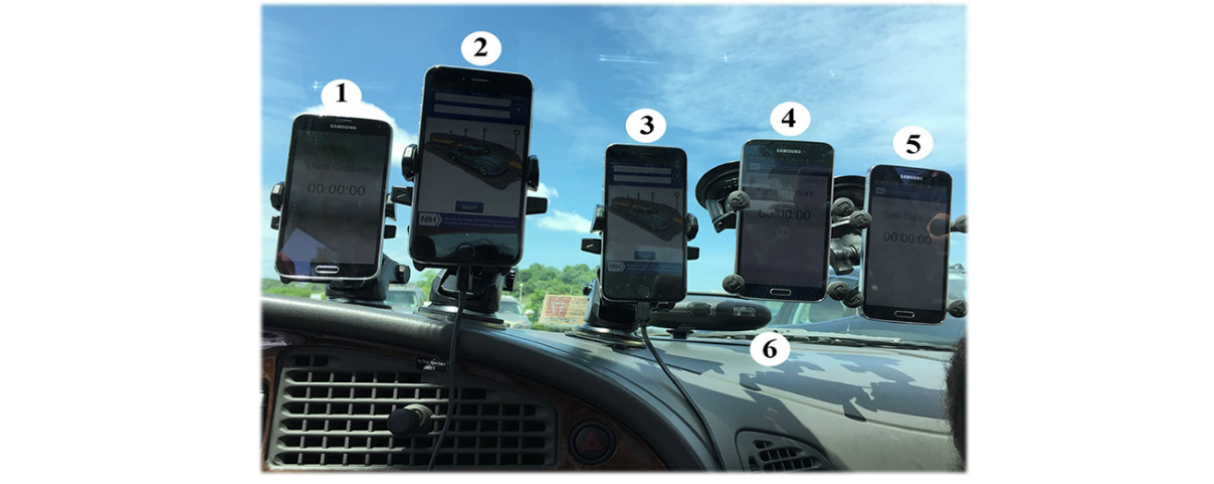
Figure 1. Smartphones used for the Virginia Tech Transportation Institute road test: iPhone devices are #2 and 3; Android devices are #1, 4, and 5; Virginia Tech Transportation Institute permanently vehicle-installed instrumentation #6.